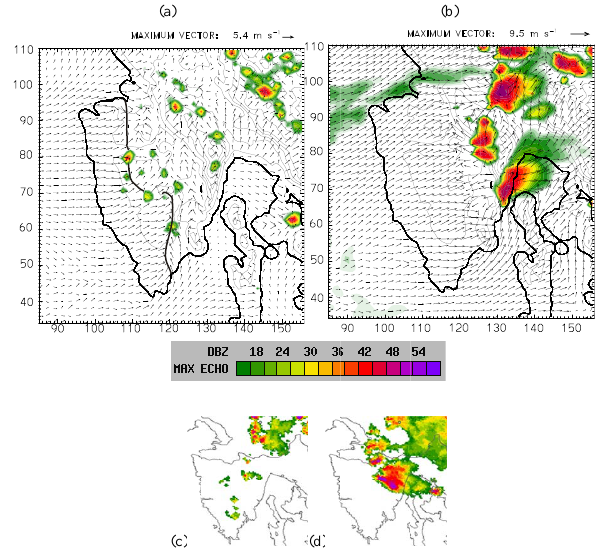
Fig. 12. (a, b) Diurnal evolution of the modelled near-surface wind (in ms − 1 , at 10ma.g.l.) associated with the maximum simulated equivalent radar reflectivity factor (dBZ) on 6 July 2009 at (a) 11:00CET and (b) 14:00CET. The every second wind vector is depicted with reference vectors near the upper right-hand corner and the thick black solid line in (a) indicates the position of the main convergence zone. (c, d) Radar reflectivity factor (dBZ) in radar images (source: ARSO – www.meteo.si) on 6 July 2009 at (c) 10:50CET and (d) 14:00CET. The radar reflectivity is given with a 3dBZ